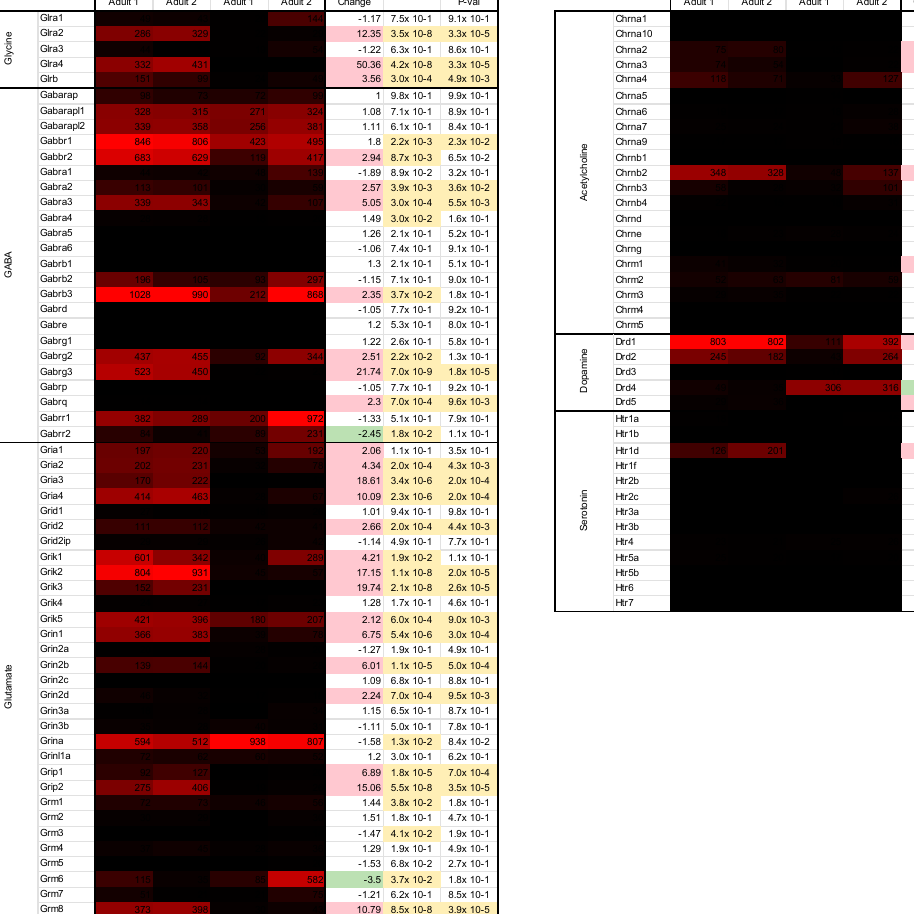
Figure 7. Gene expression levels and fold changes of neurotransmitter receptors. Fold change shows receptor expression of all neurotransmitter types in adult Lgr5 + cells. Differentially expressed genes were defined by a fold change ≥ 2 or ≤ − 2, p -value < 0.05, and false discovery rate (FDR) < 0.05.